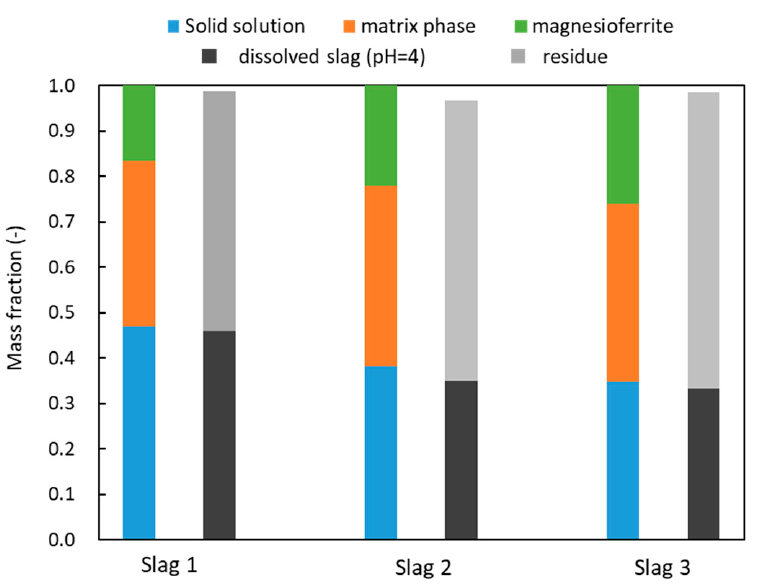
Figure 7. Mass fractions of mineral phases compared with that of dissolved slag in hydrochloric acid solution at pH 4.